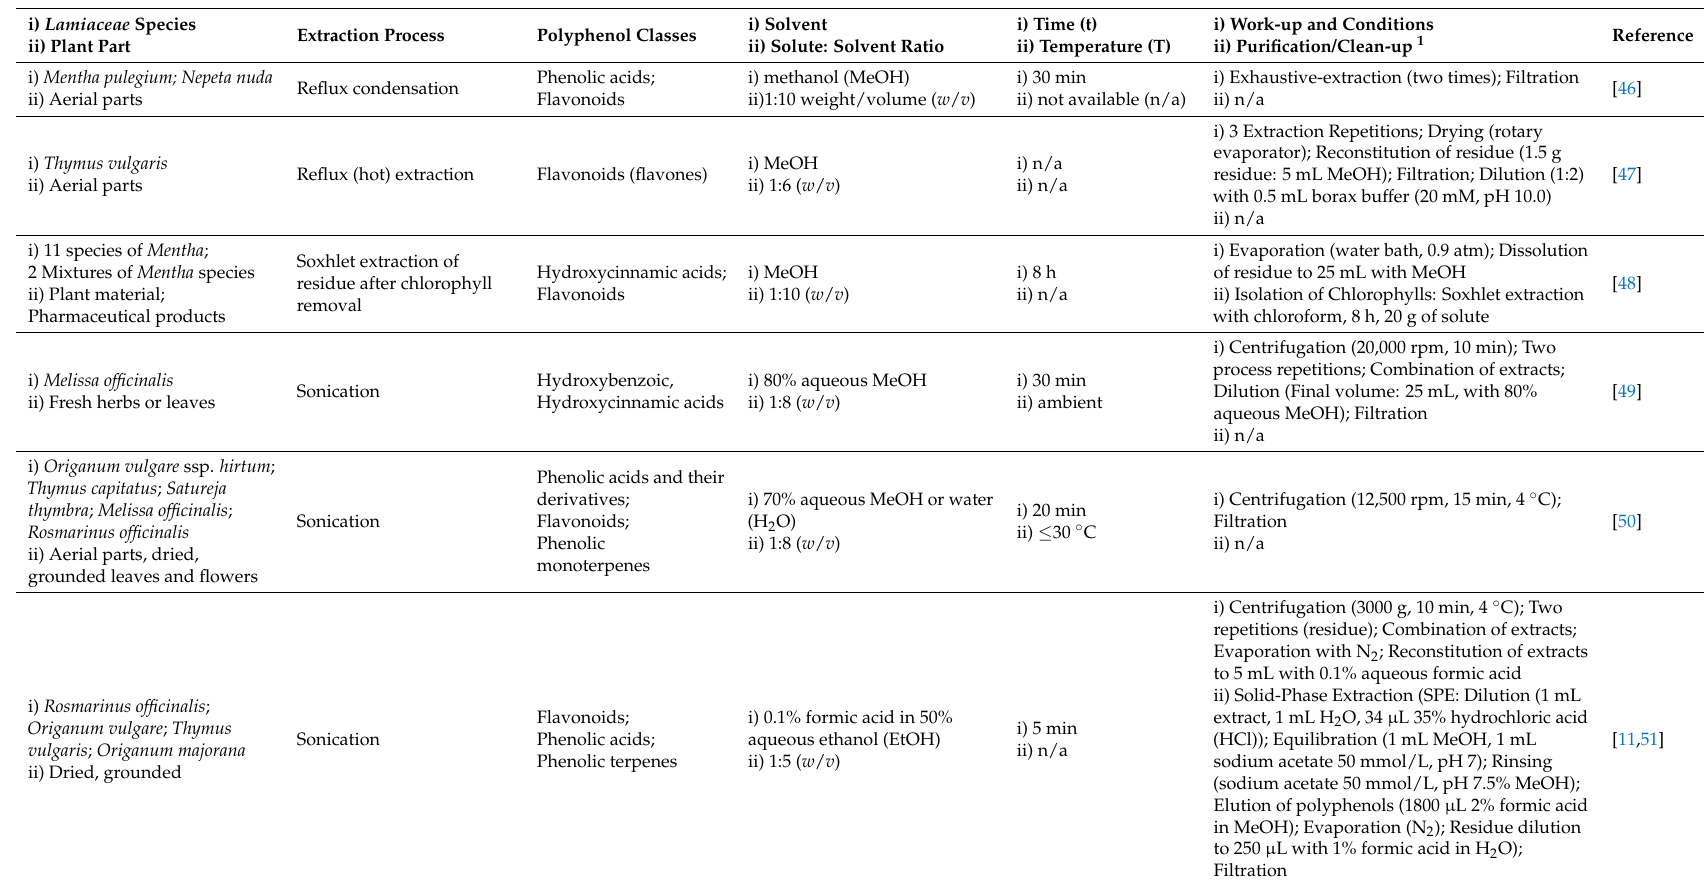
Table 1. Extraction processes for polyphenolic constituents from Lamiaceae